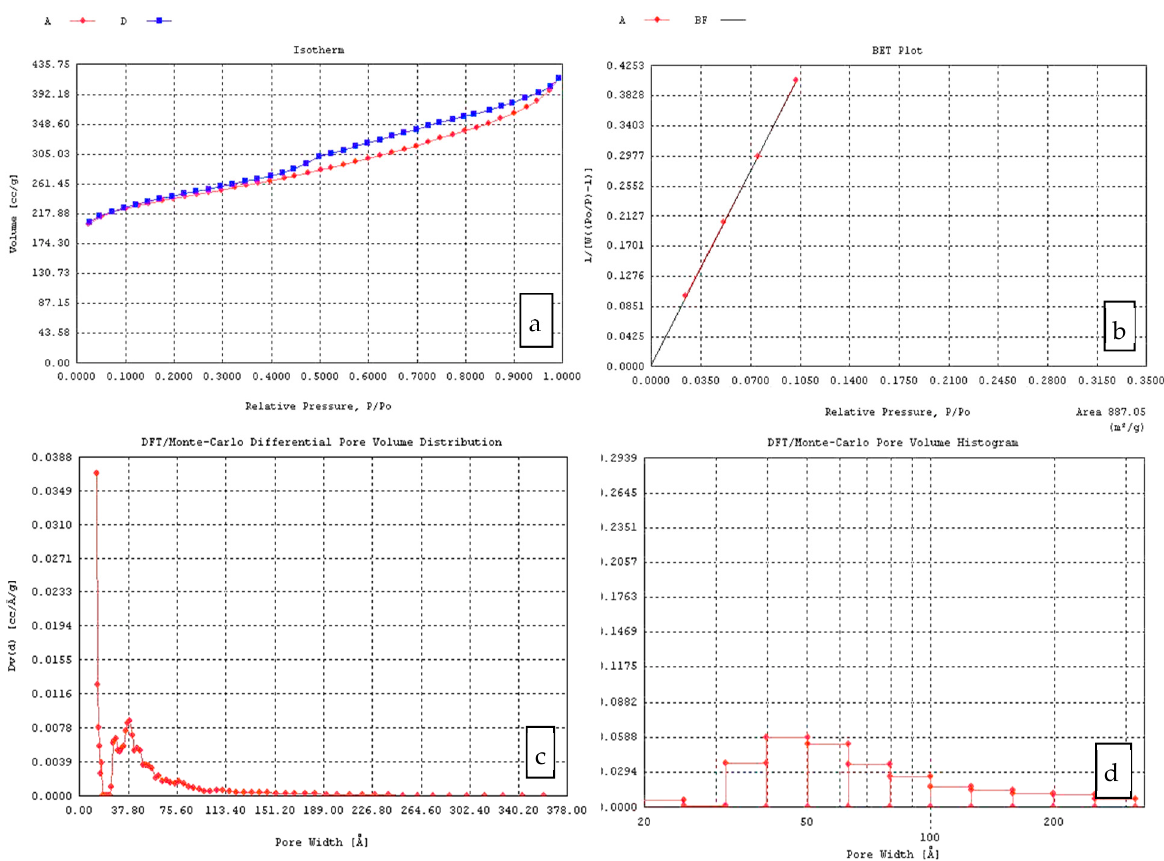
Figure 5. Variant X4 (after gel impregnation in carbon felt and pyrolysis): ( a ) Adsorption isotherm; ( b ) BET plot; ( c ) Pore volume distribution; ( d ) Pore volume histogram.